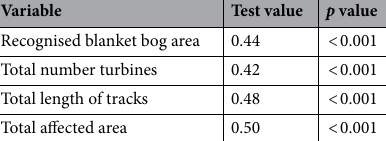
Table 5. Normality test results of all variables studied at European regions NUTS level